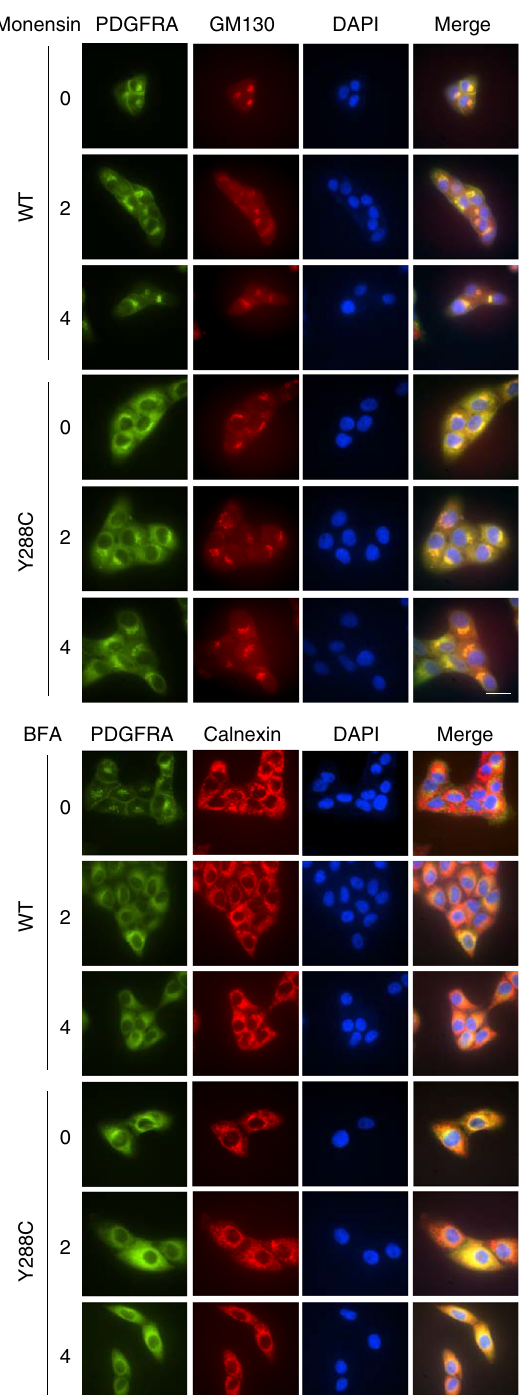
Fig. 4 Y288C protein activates signaling pathways in distinct subcellular compartments. a Phosphorylation of the Y288C receptor at the ER and Golgi was analyzed by western blot of the OptiPrep gradient ultracentrifugation resolved membrane fractions. MCF10A cells stably expressing PDGFRA WT or Y288C were serum-starved for 16 h and treated with or without monensin (500 nM) or BFA (1 μ M) for 2 or 4 h respectively. b Cells were fi xed and stained with anti-PDGFRA (green), anti-GM130 (Golgi marker; red) or anti-calnexin (ER marker; red), and DAPI (nucleus; blue) to examine the subcellular localization of PDGFRA after treatments. Bar, 25 μ m. c Protein was extracted and analyzed for the activities of Akt, STAT3, STAT5, ERK1/2 signaling pathways by western blot with indicated antibodies. Corresponding total proteins were used as loading